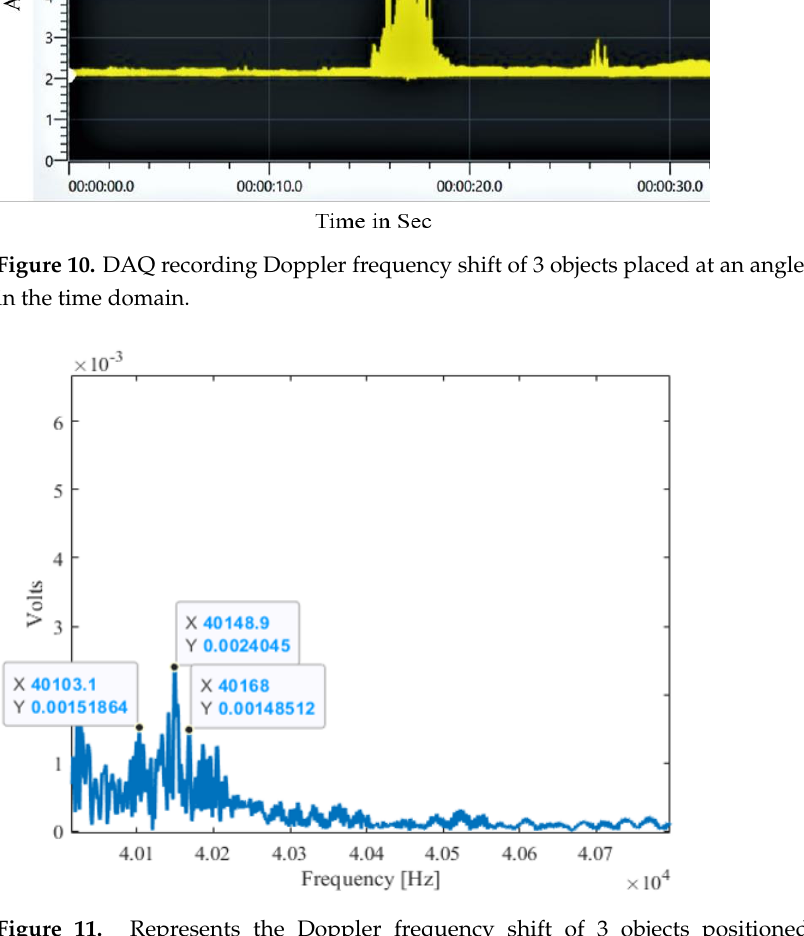
Figure 11. Represents the Doppler frequency shift of 3 objects positioned at an angle of 20 ◦ , 35 ◦ , and 50 ◦ in the frequency domain, respectively. Table 4. The proposed method measures the estimation of vehicle speed, Doppler frequency shift, and azimuthal angle.